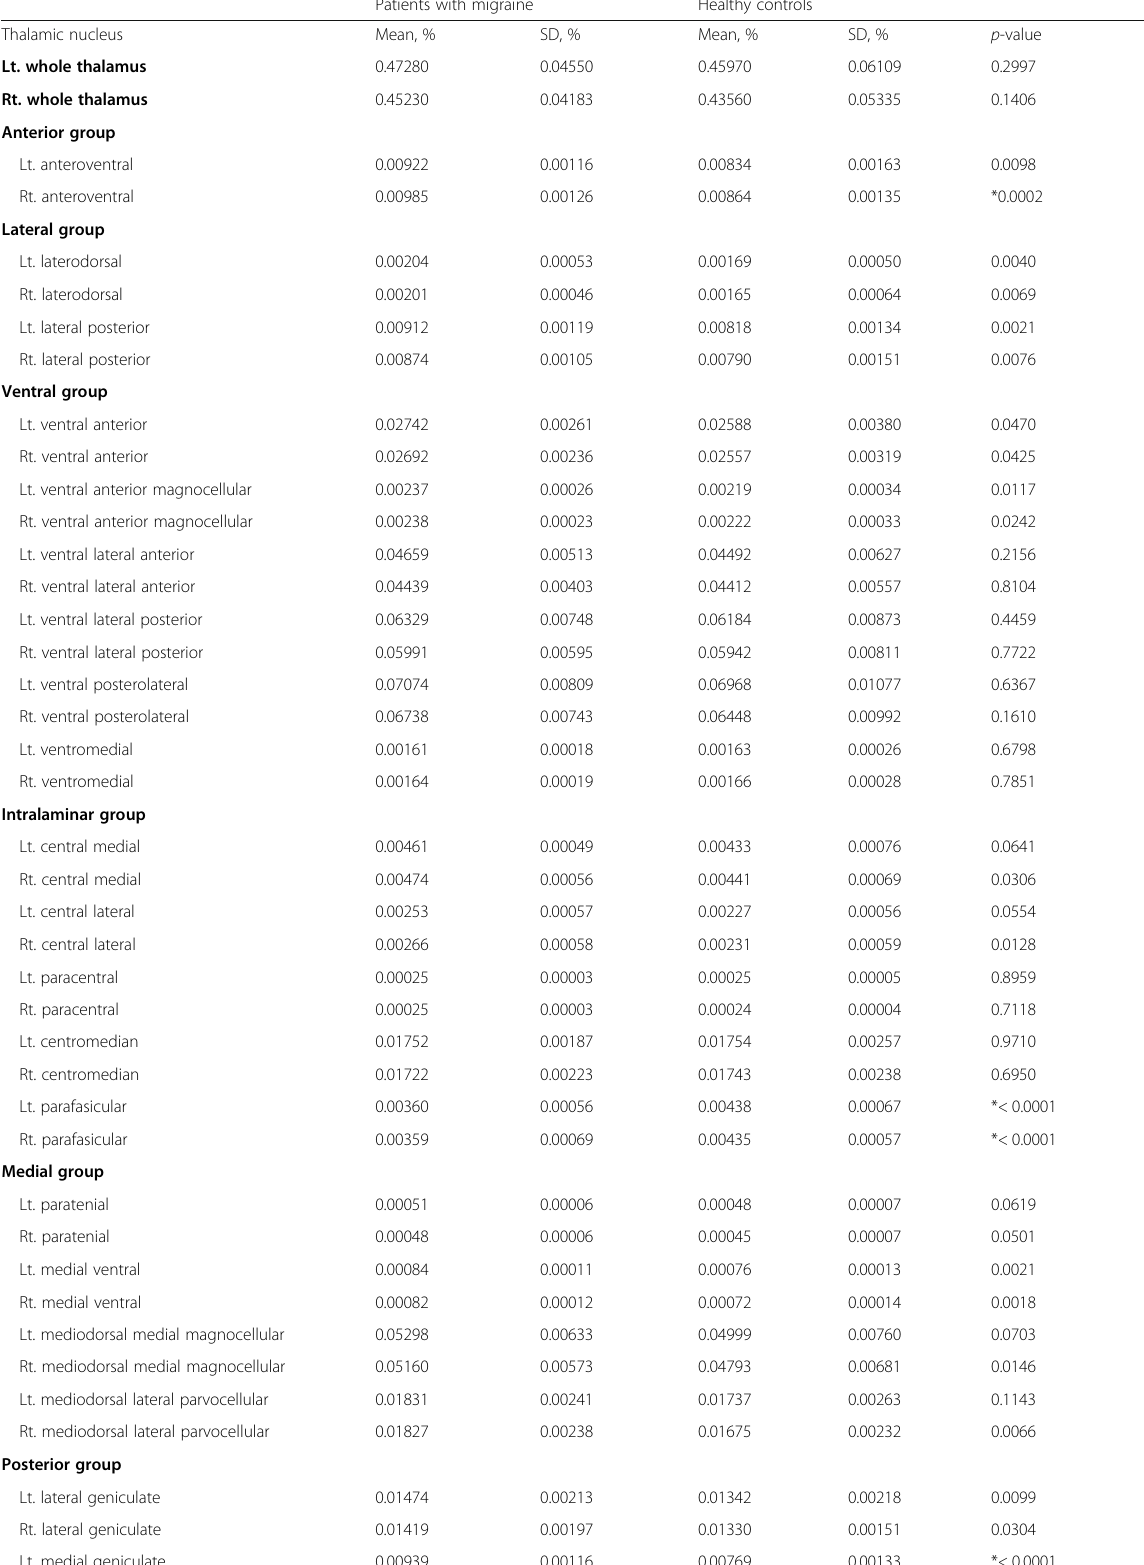
Table 2 Differences in the individual thalamic nuclei volumes between patients with migraine and healthy controls Patients with migraine Healthy